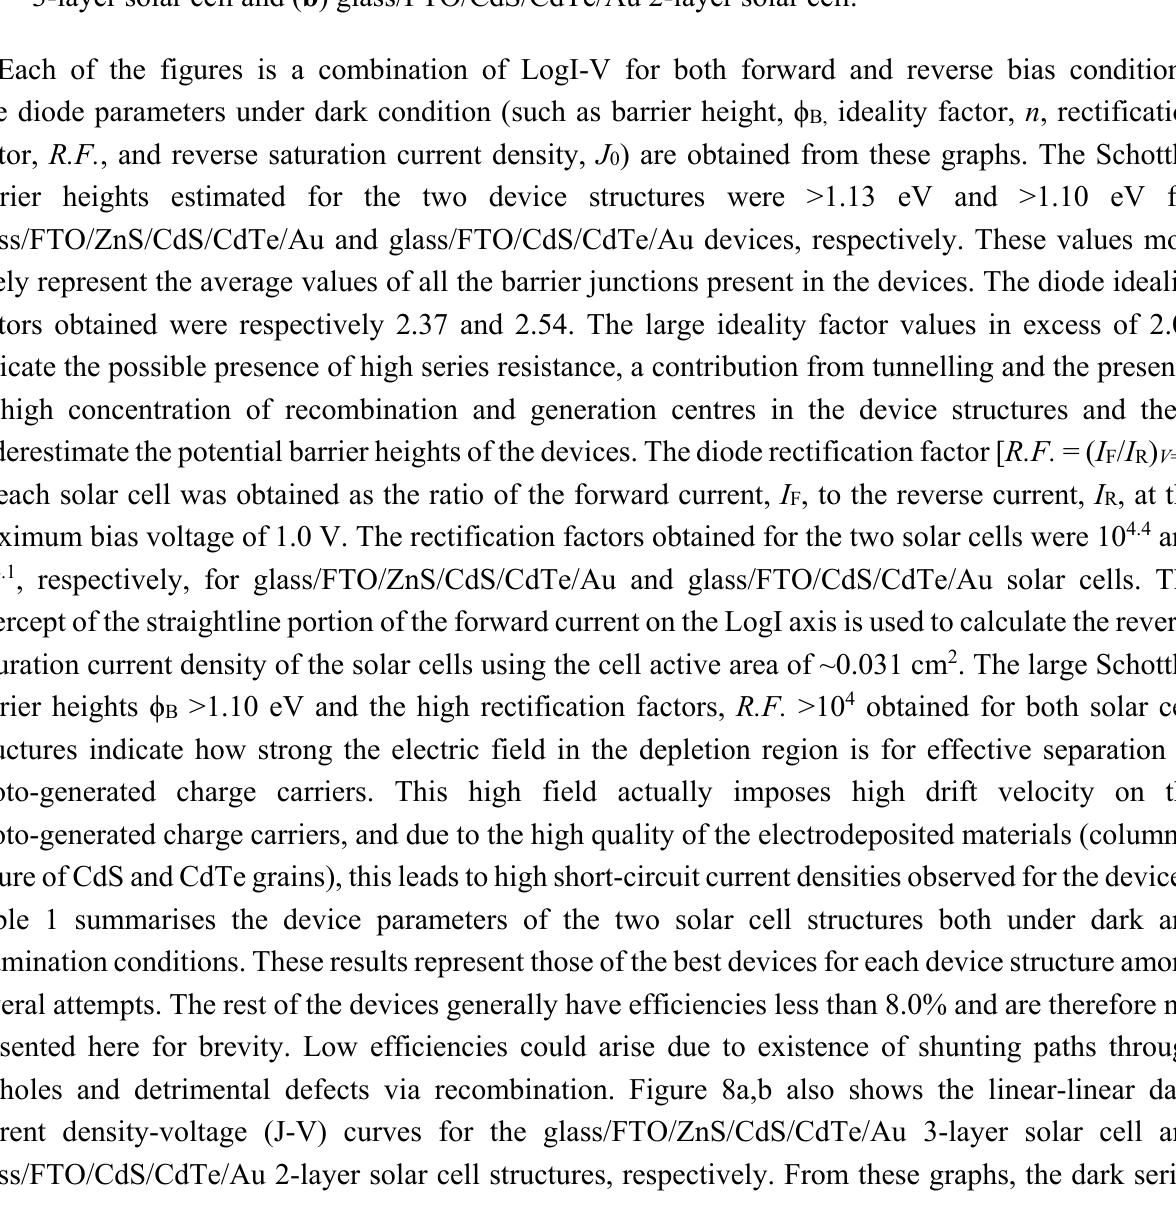
Figure 7. LogI vs. voltage under dark conditions for ( a ) glass/FTO/ZnS/CdS/CdTe/Au 3-layer solar cell and ( b ) glass/FTO/CdS/CdTe/Au 2-layer solar